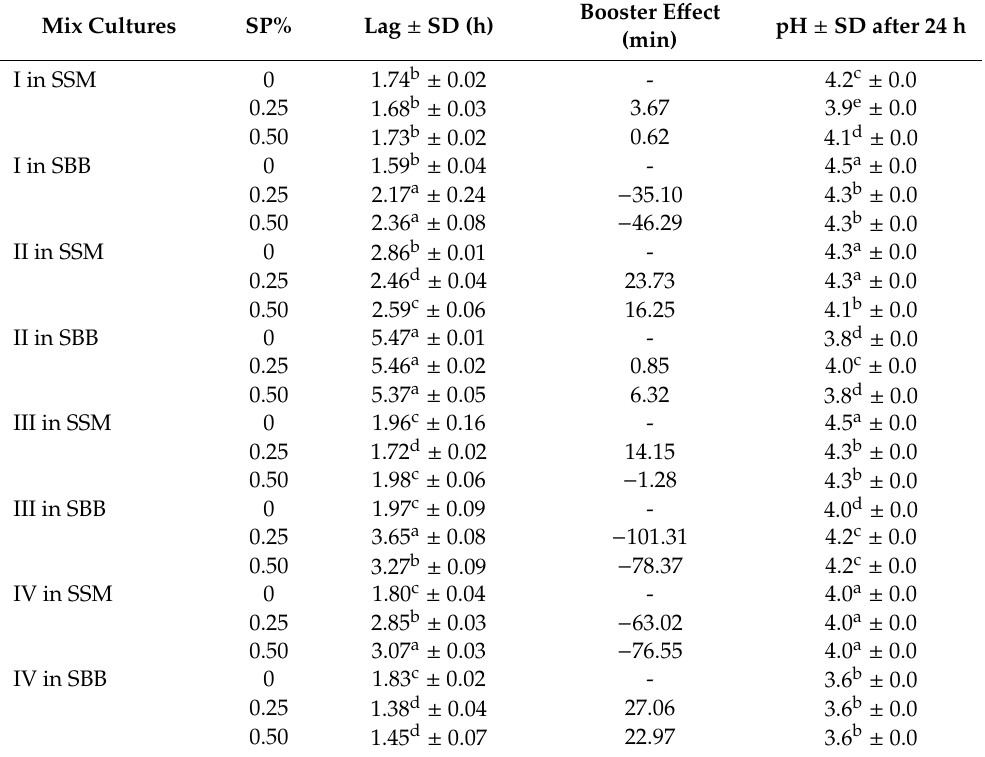
Table 2. Boosting e ff ect of the three concentrations of A. platensis on mix culture. Mix Cultures SP% Lag ± SD